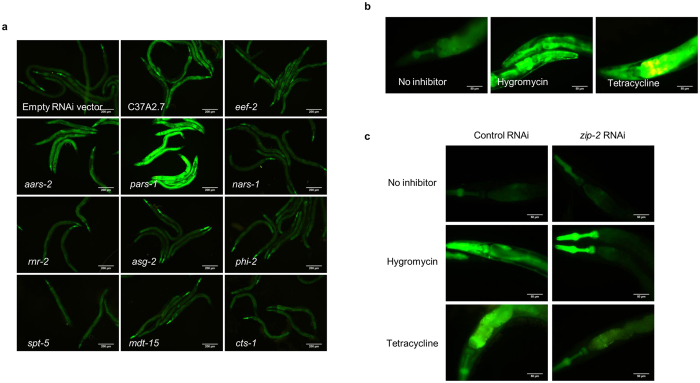
Translational inhibition induces ugt-29 expression in the absence of infection.(a) Representative fluorescence micrographs (100× magnification) of ugt–29::GFP reporter worms grown on RNAi lawns that target and inactivate several individual components of essential processes in worms. Worms were exposed to the RNAi lawn for 48 hours starting at the L1 stage. Scale bar, 200 μm. (b) Representative fluorescence micrographs (400× magnification) of ugt–29::GFP reporter worms challenged with chemical protein synthesis inhibitors, 157 μg/ml hygromycin or 100 μg/ml tetracycline for 24 hours. Scale bar, 50 μm. (c) ugt–29::GFP worms were fed with RNAi clones of either the empty expression vector (control) or zip–2 for 48 hours prior to treatment with 157 μg/ml of hygromycin or 100 μg/ml of tetracycline. The exposure time and gain factor are similar for all the micrographs taken at the same magnification. Scale bar, 50 μm.